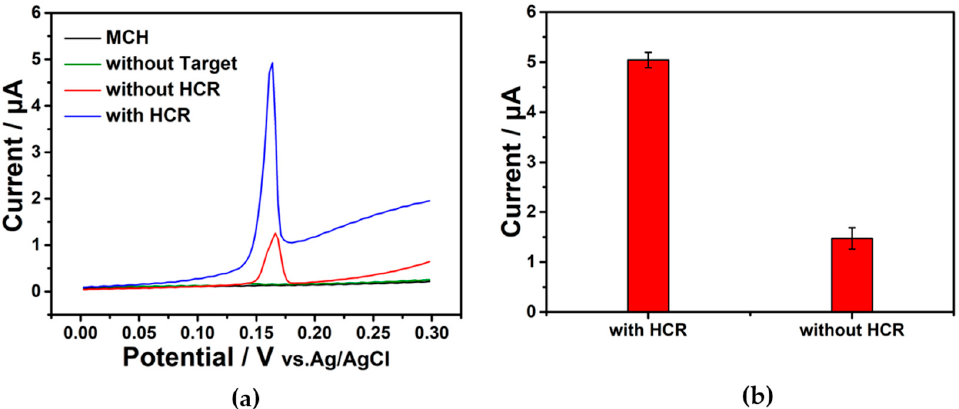
Figure 3. ( a ) Plot of CV without HCR, with HCR, and without target; and only MCH modification. ( b ) Peak current value of the E-DNA sensor without or with HCR amplification. Each one was repeated 3 times. Target: 1 nM.